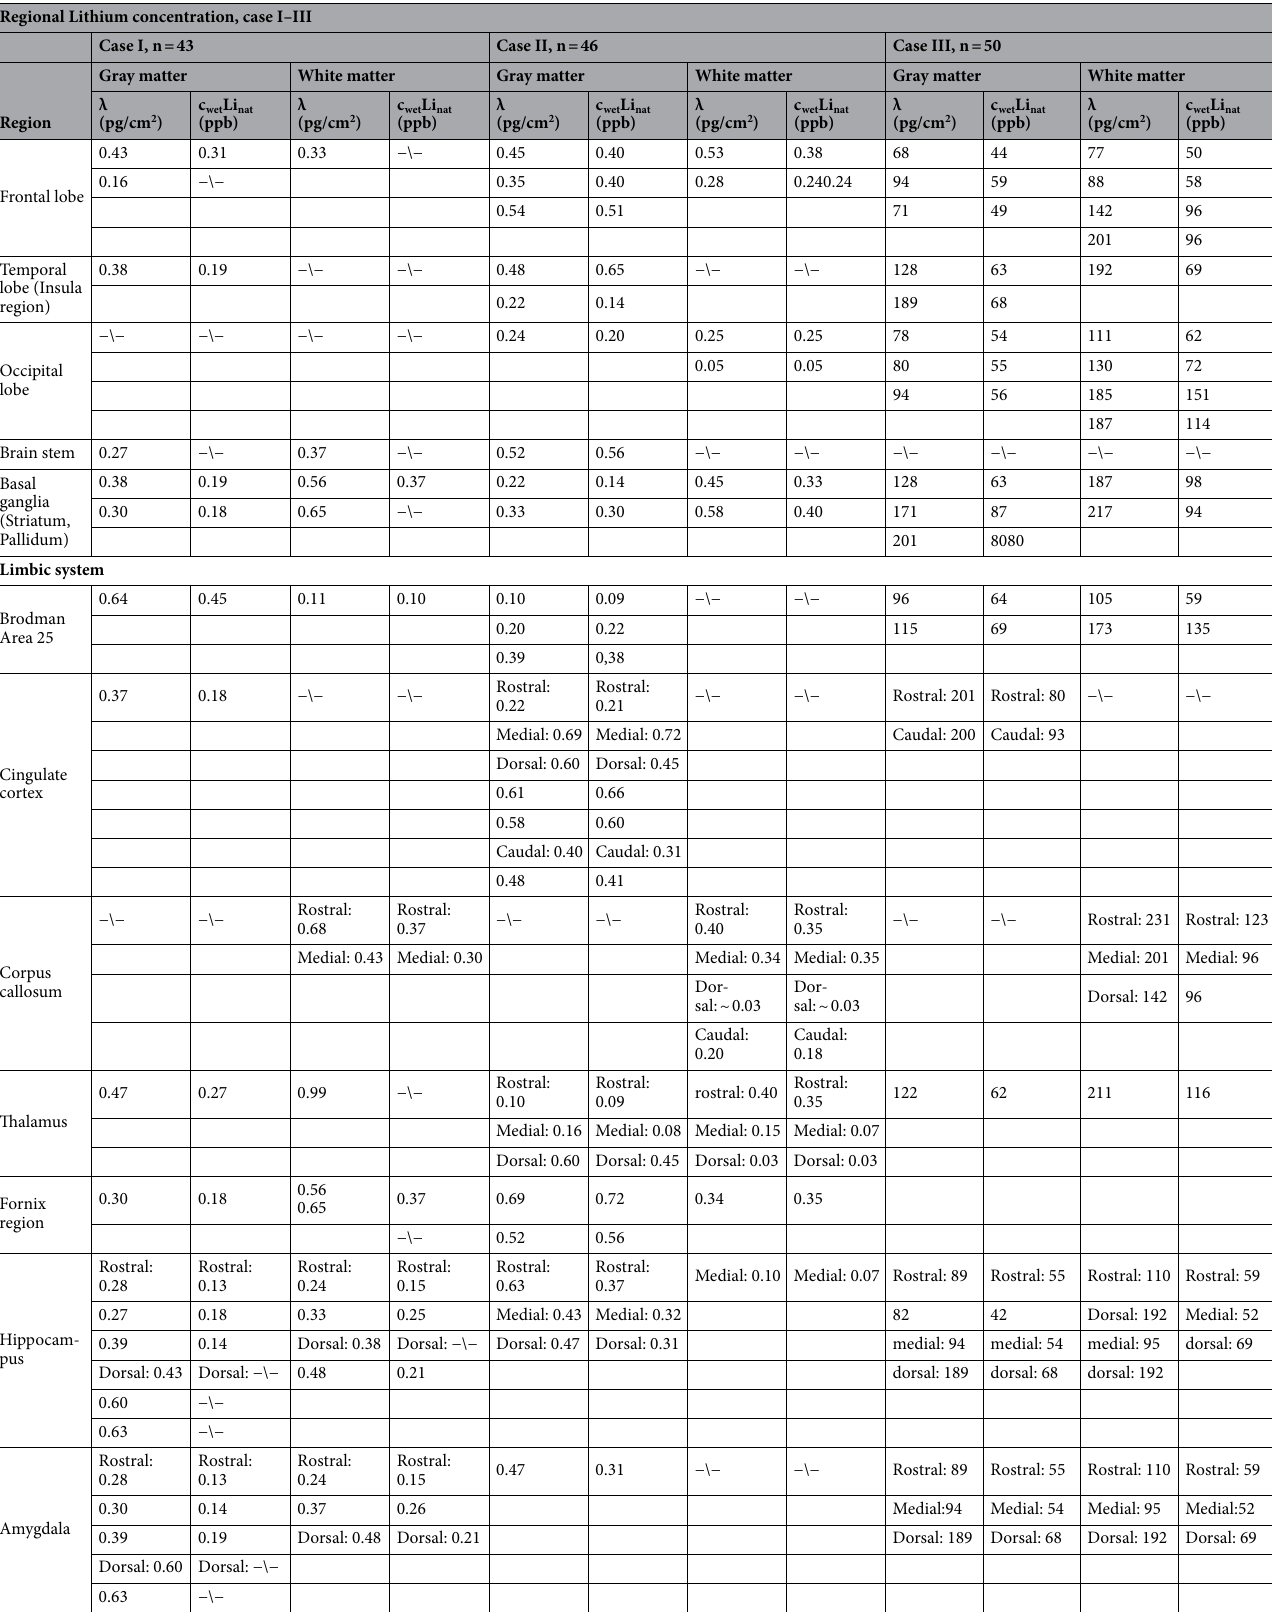
Table 3. Regional lithium concentration, case